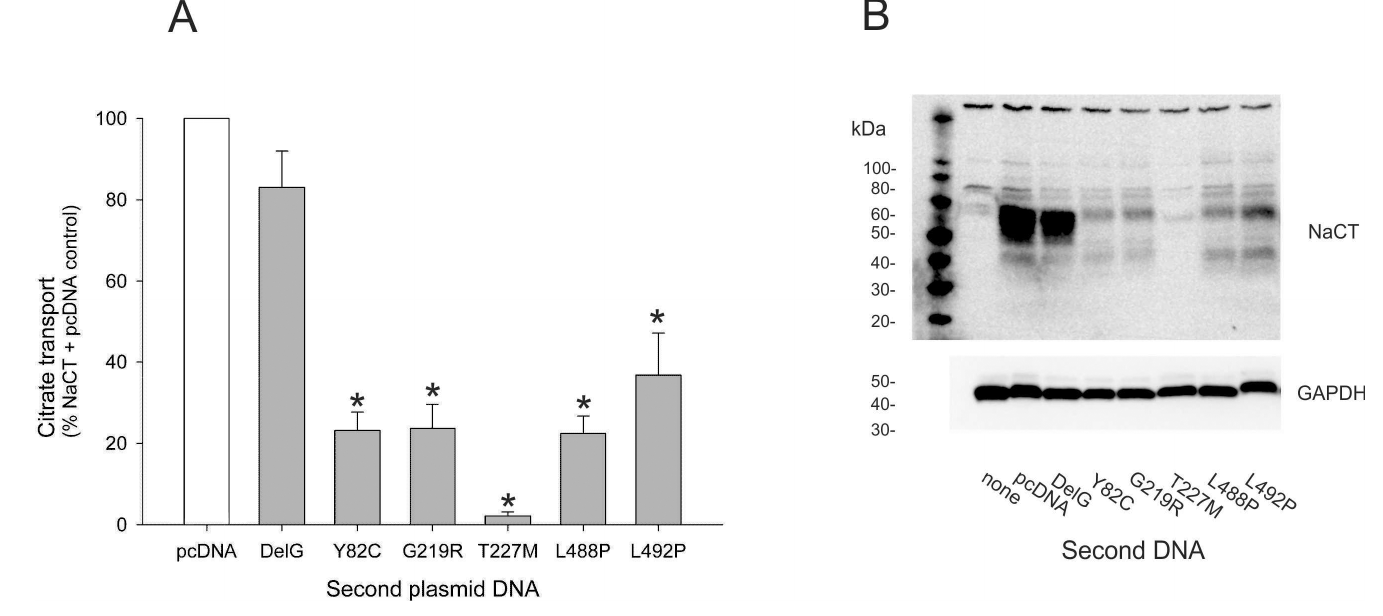
Figure 5. Effects of cotransfection of wild-type NaCT with vector plasmid (pcDNA) or mutant transporters. (A) Citrate transport activity. All groups were transfected with the same amount of wild-type NaCT DNA and a second plasmid. Activity is expressed as a percentage of the NaCT + pcDNA control group. All counts were corrected for background counts determined from cells transfected only with pcDNA plasmid. Bars are means ± SEM, n = 3–5, or range, n = 2 (DelG). * denotes p < 0.05 relative to the NaCT + pcDNA group. (B) Western blots. Duplicate blots were probed with anti-NaCT (top) and anti-GAPDH (bottom) antibodies. Groups were the same as for panel (A). The samples in the lane next to the size standards (labeled none) were transfected only with pcDNA, the other samples had two plasmid DNAs (NaCT and a second plasmid). All cells were transfected with the same total amount of